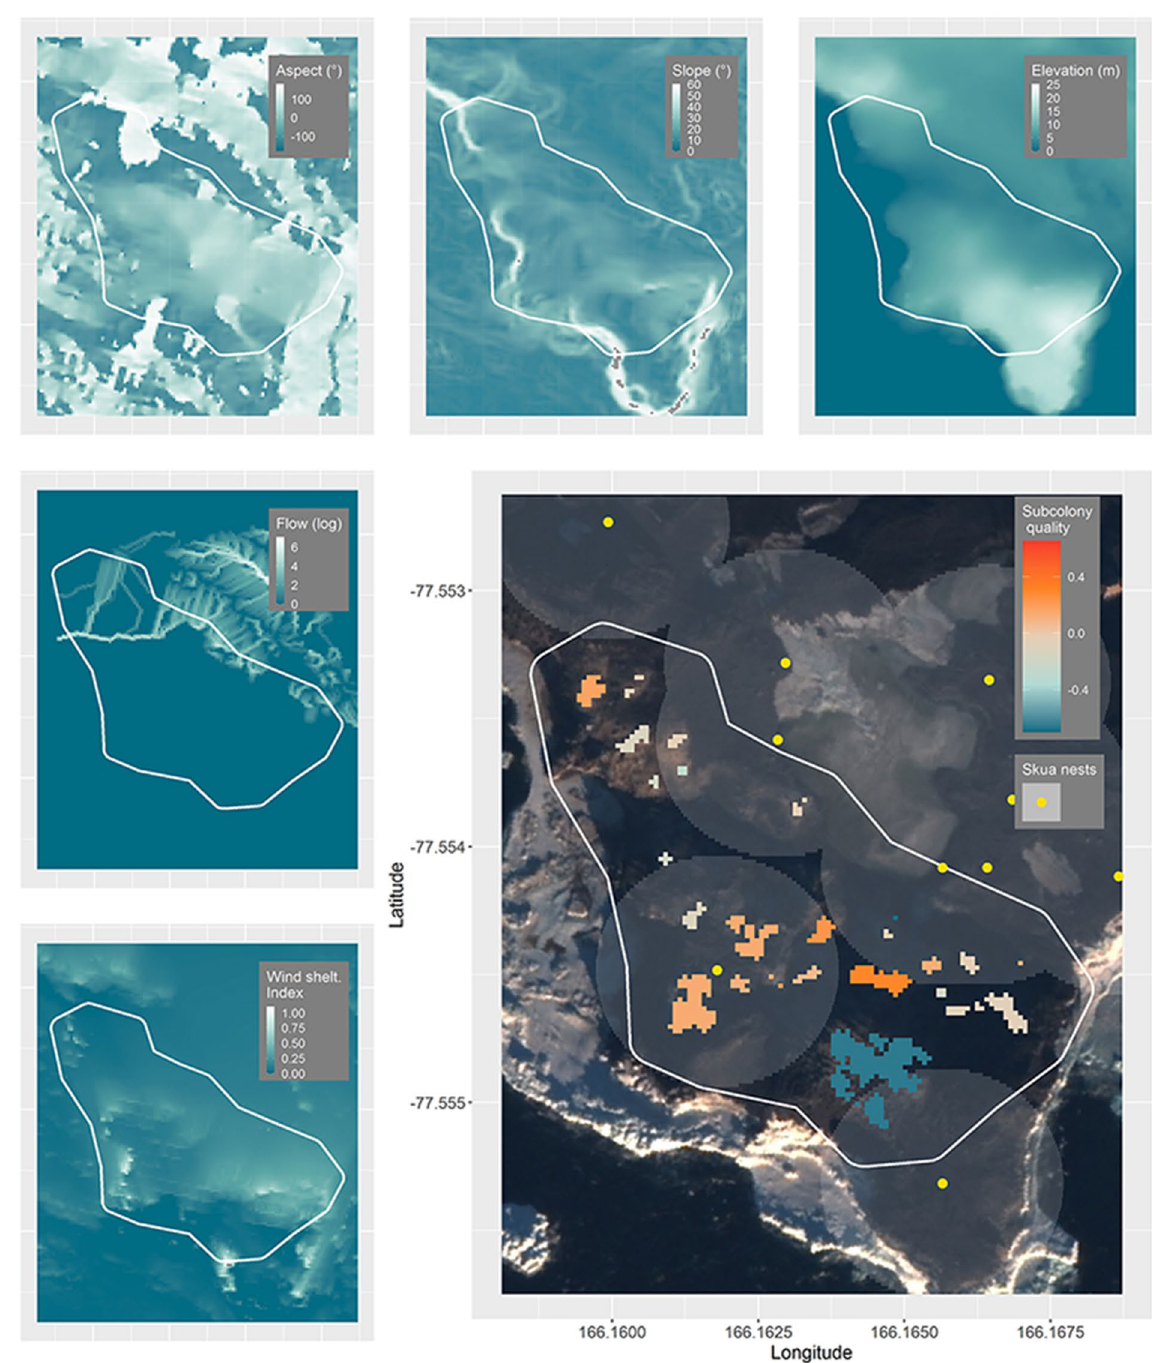
Figure 6. Spatial habitat covariate layers and predicted subcolony quality at Cape Royds, Ross Island, Antarctica (background WorldView-2 satellite image, November 27, 2015, copyright 2015 DigitalGlobe, NextView License). Positive values (orange) indicate above average subcolony quality and negative values (teal) indicate below average subcolony quality relative to the mean at Cape Royds. Yellow points indicate locations of skua nests included in the model and grey circles show the 50 m radius used to indicate skua nest proximity. To aid visualization, one subcolony with very low predicted quality was not included on the color scale and appears as a small grey pixel in the Northwest section of the colony. This subcolony had the lowest predicted quality of −